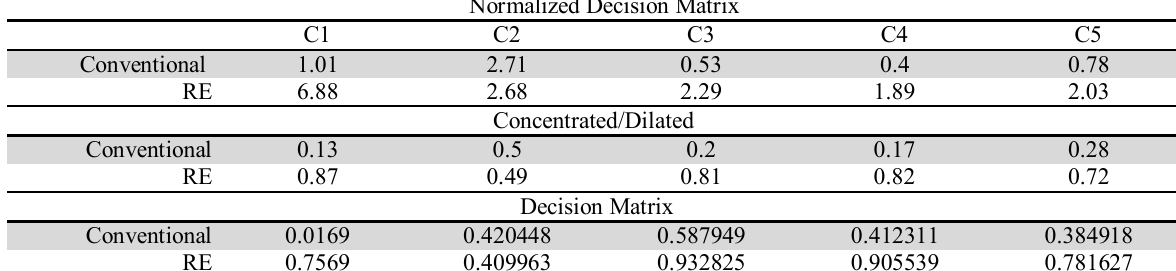
Final selection of best manufacturing process using max-min principle